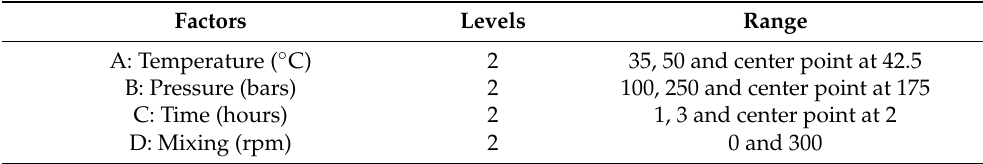
Table 1. Factorial design parameters.